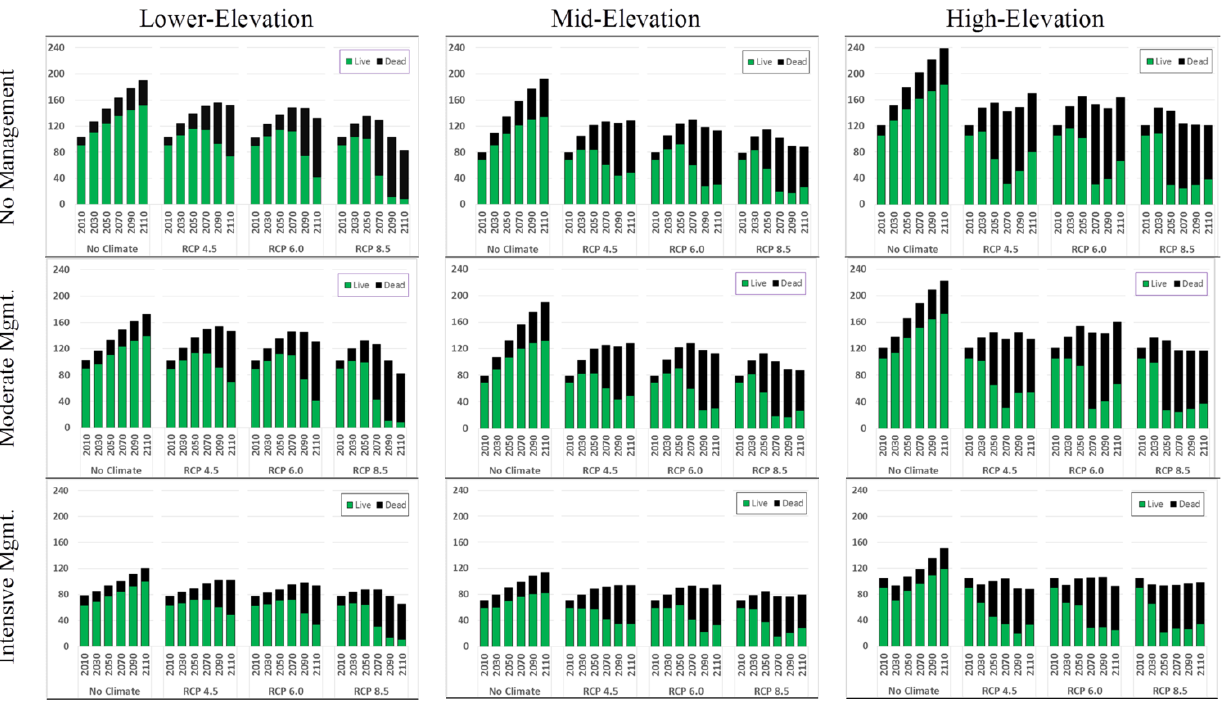
Figure 4. Average estimated carbon stocks in ponderosa pine stands. Each cell contains total living and dead carbon (tons/hectare) projected over 100 years (2010 to 2110) under four climate scenarios. Rows show average stand carbon grouped by three management scenarios. Columns display average carbon stocks in stands grouped by